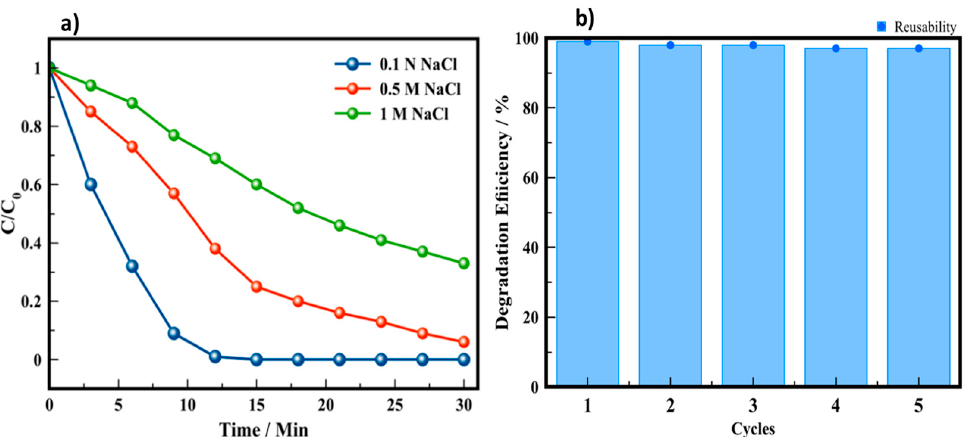
Figure 8. ( a ) Supporting electrolyte effect on electrocatalytic activity and ( b ) reusability cycles of the BWO-600 electrode.